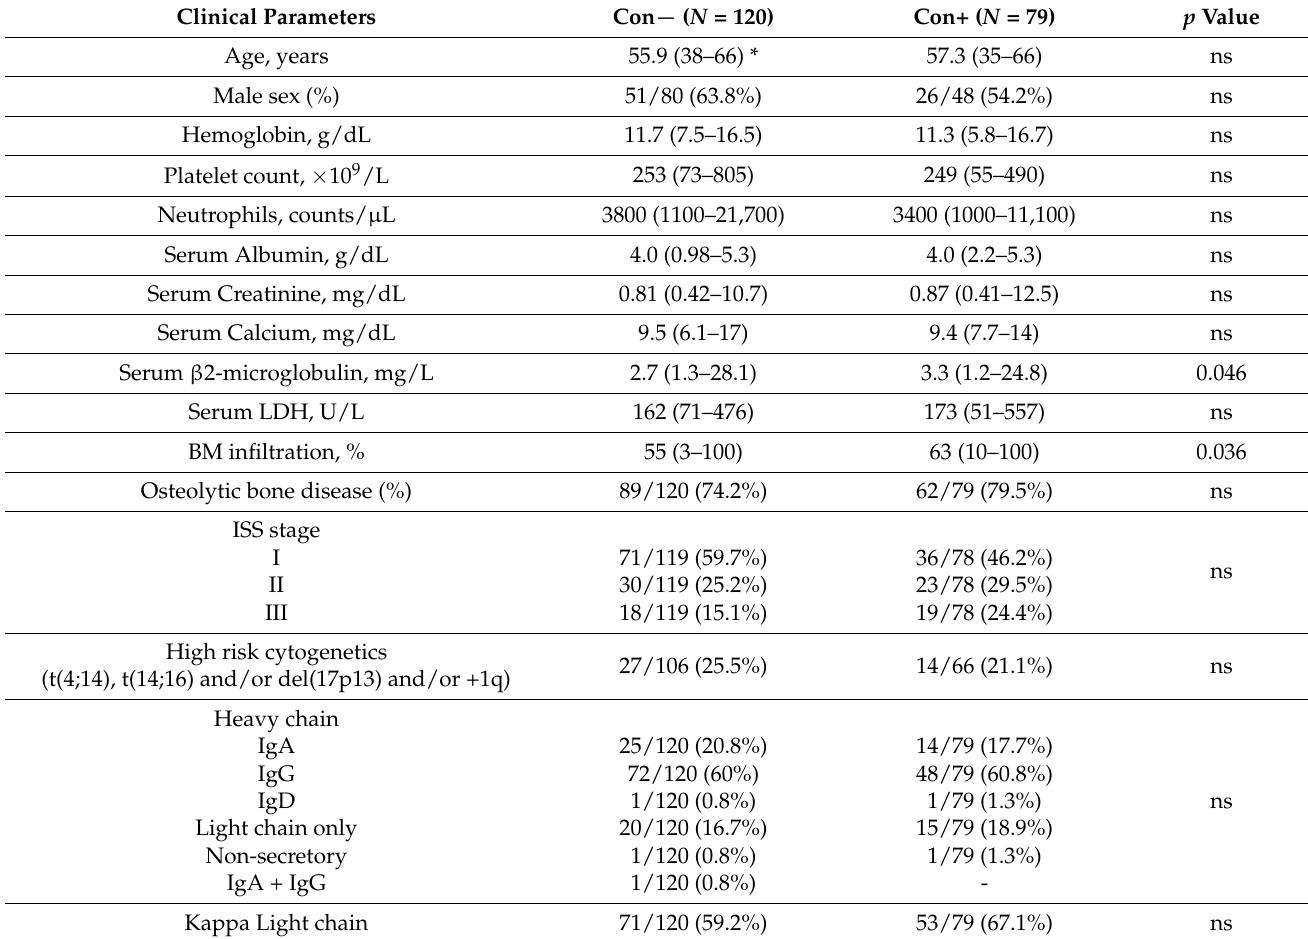
Table 1. Association of ASCT contamination with baseline clinical features of patients with MM. Clinical